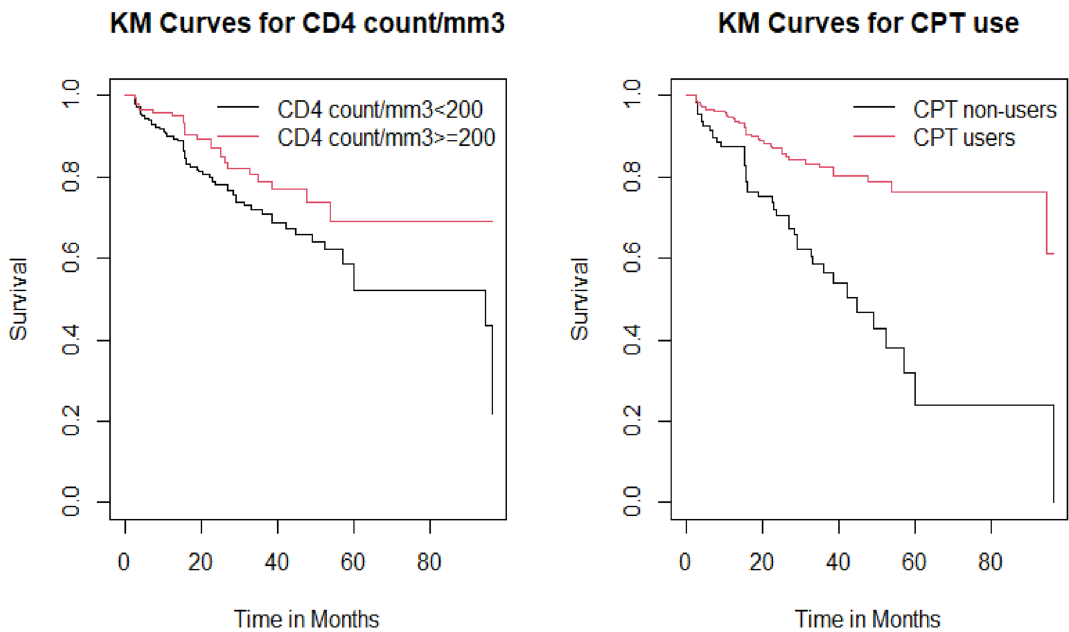
Figure 3. Survival curves for CD4 count/mm 3 , and CPT use of TB, and HIV co-infected adults who were on ART at Mettu Karl Referral Hospital, Ethiopia, 2014–2022 (n =